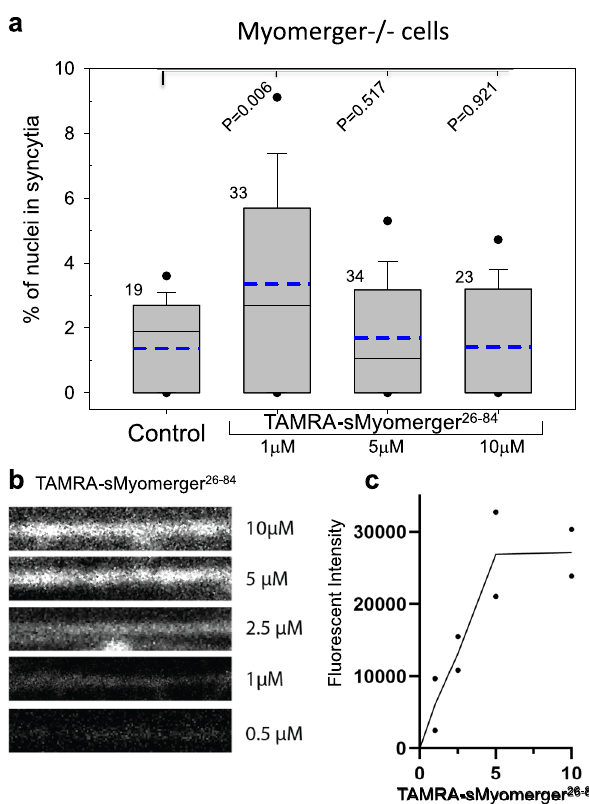
Fig. 10 Membrane concentration of sMyomerger 26-84 that promotes the hemifusion-to-fusion transition in Myomerger-de fi cient C2C12 cells. a , b After 3 days in the differentiation medium (DM) unlabeled Myomerger-de fi cient C2C12 cells were washed and incubated for 10 min in the DM with different concentrations of TAMRA-sMyomerger 26-84 . Then the cells were thoroughly washed to remove unbound peptide, and either fi xed for analysis of plasma membrane-associated TAMRA fl uorescence ( b ) or incubated in the DM for 50 more minutes and fi xed for fusion quanti fi cation ( a ). a Fusion was quanti fi ed by assessing formation of multinucleated cells as the ratio of nuclei in the cells with ≥ 2 nuclei to the total number of nuclei. N , the number of randomly selected fi elds of view examined for each condition over two independent cell preparations, is indicated to the left of the box associated with that data. Box-and-whisker plots show median (center line), mean (blue line), 25 – 75th percentiles (box), 10 – 90th percentiles (whiskers), and 5 – 95th percentiles (solid circles). P -values were calculated using a two-tailed unpaired t -test. b The representative images of membrane-associated TAMRA labeling for the cells treated with different concentrations of TAMRA-sMyomerger 26-84 . c Quanti fi cation of the intensity of membrane-associated TAMRA fl uorescence in two independent experiments shown as points with line connecting the means for each of the peptide concentrations